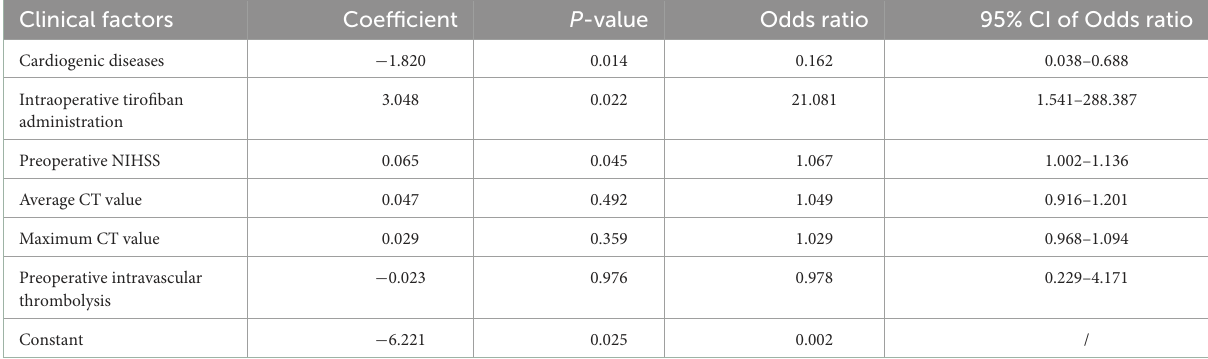
TABLE 2 The multiple logistic regression analysis of the clinical